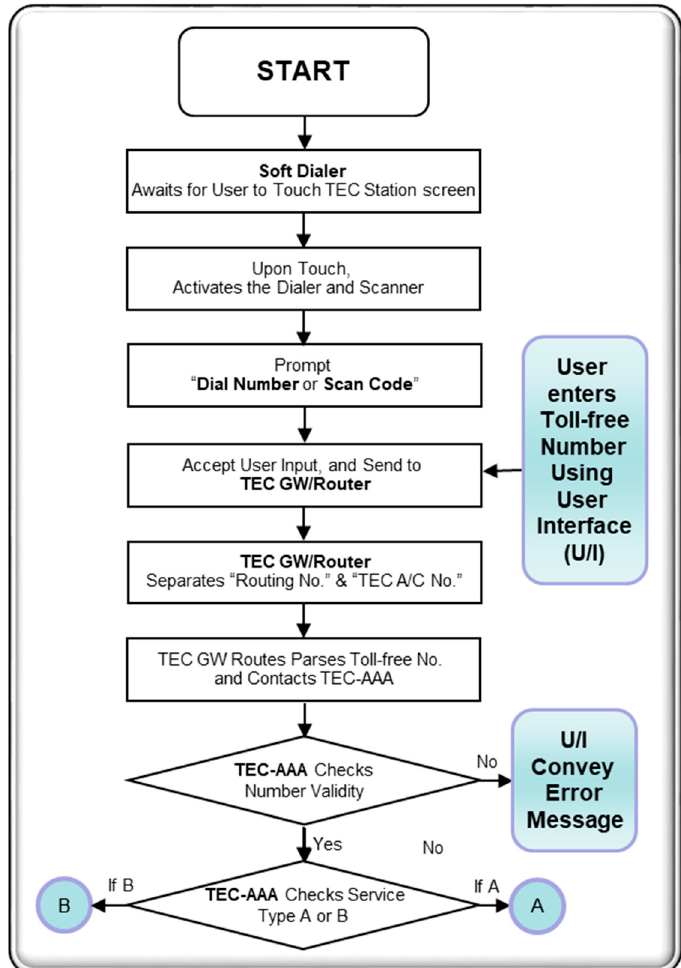
Figure 2. Routing, and resolution of service type.